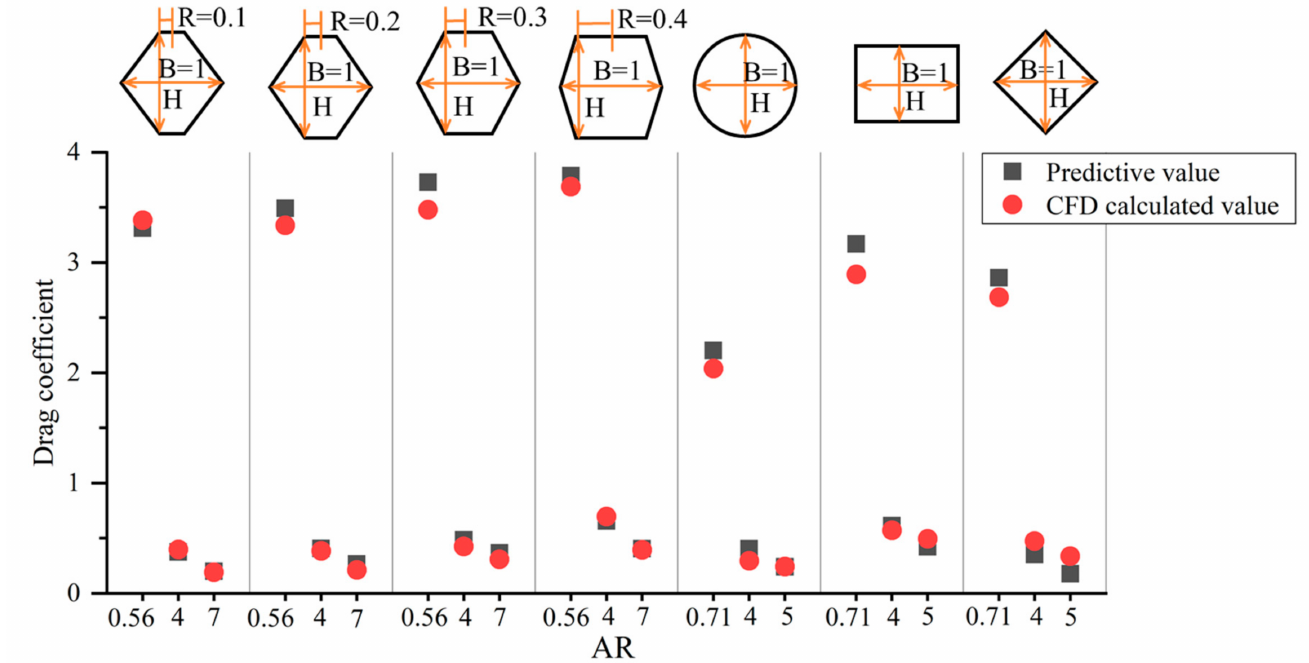
Figure 14. Drag coefficient prediction